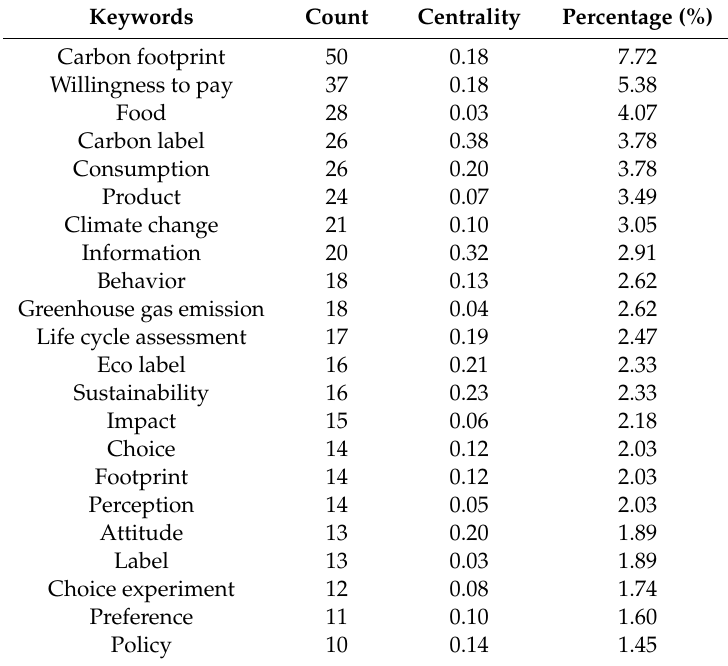
Table 6. Descriptive statistics of the keywords.